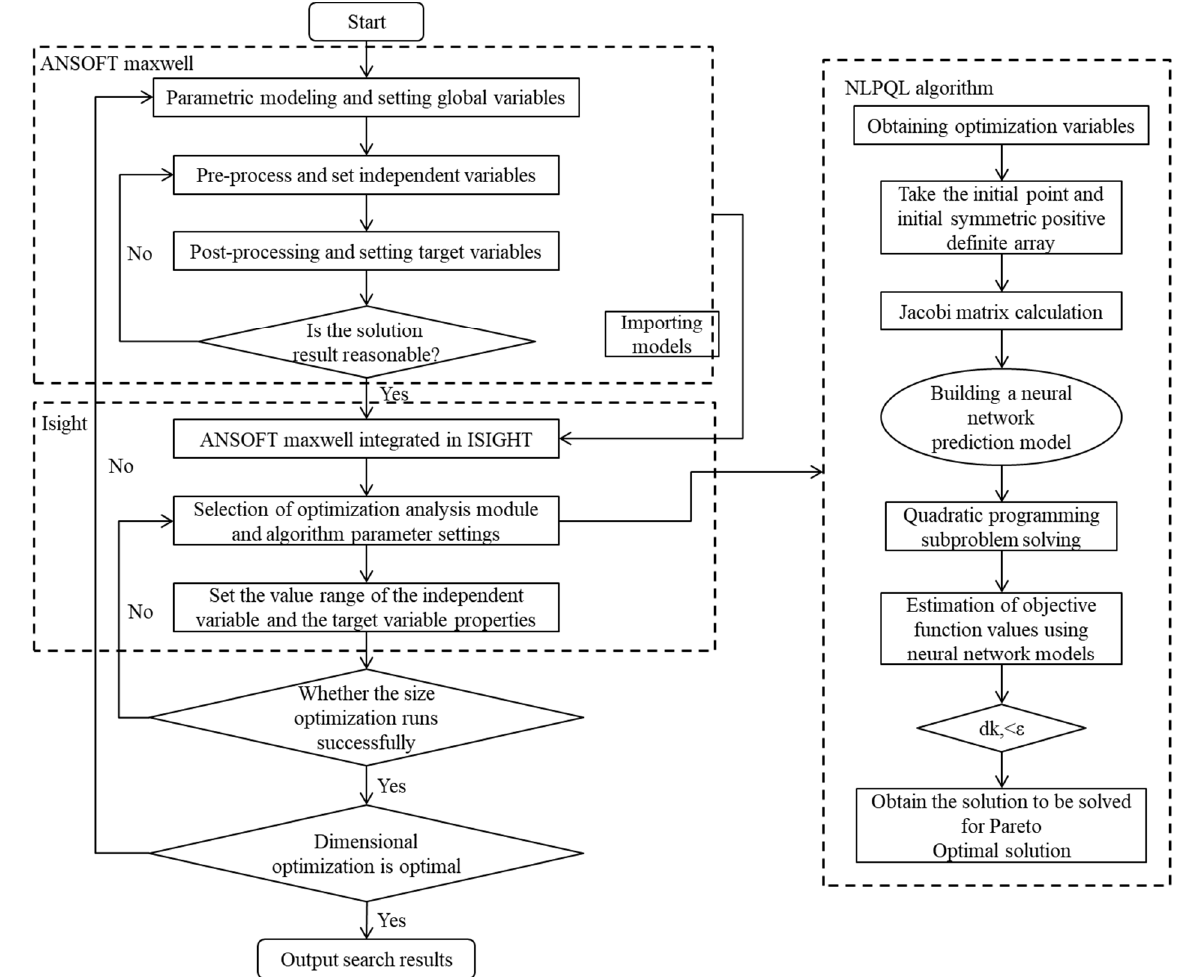
Figure 8. Optimization flow chart.